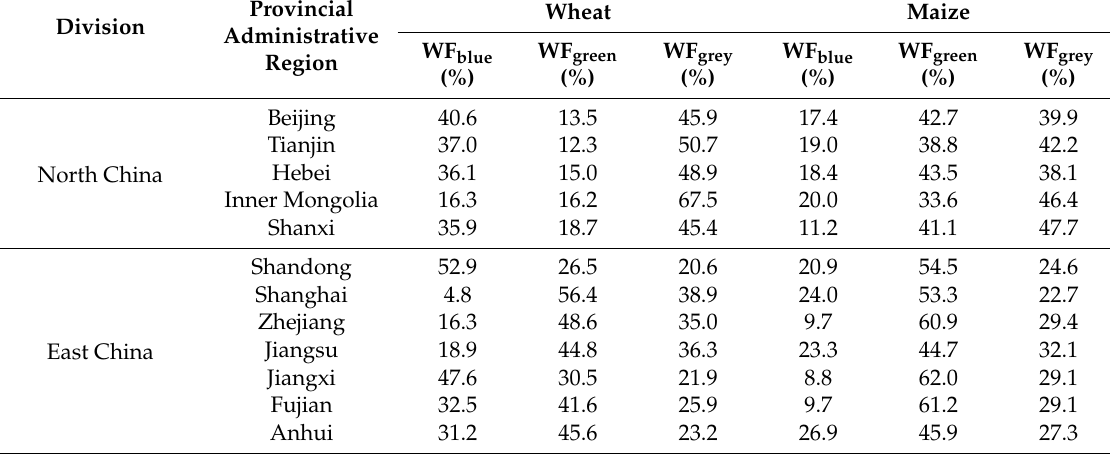
Figure 6. Mean value of the total water footprint of wheat ( a ) and maize ( b ) from 2012 to 2016. Table 4. The proportion of green water, blue water, and the grey water footprint of wheat and maize from 2012 to 2016.